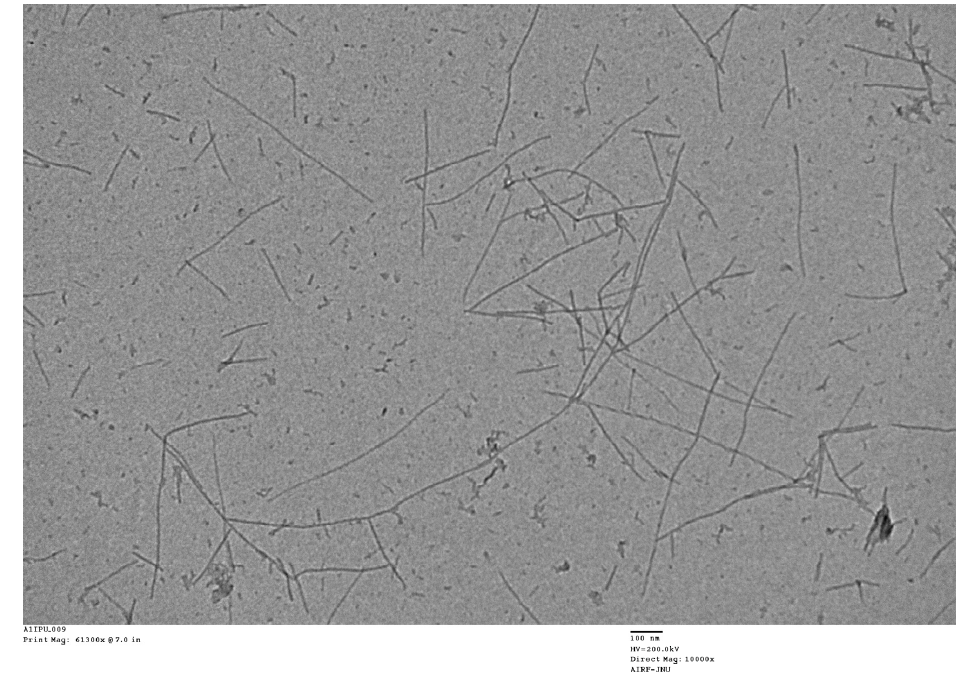
Figure 8. Transmission electron microscopy images of ( A )—A β 42 control incubated at 37 °C for 48 h; ( B )—A β 42 + 44 μ M RES incubated at 37 °C for 48 h; and ( C )—A β 42 + 44 μ M AJM incubated at 37 °C for 48 h. Images were presented at 100 nm.